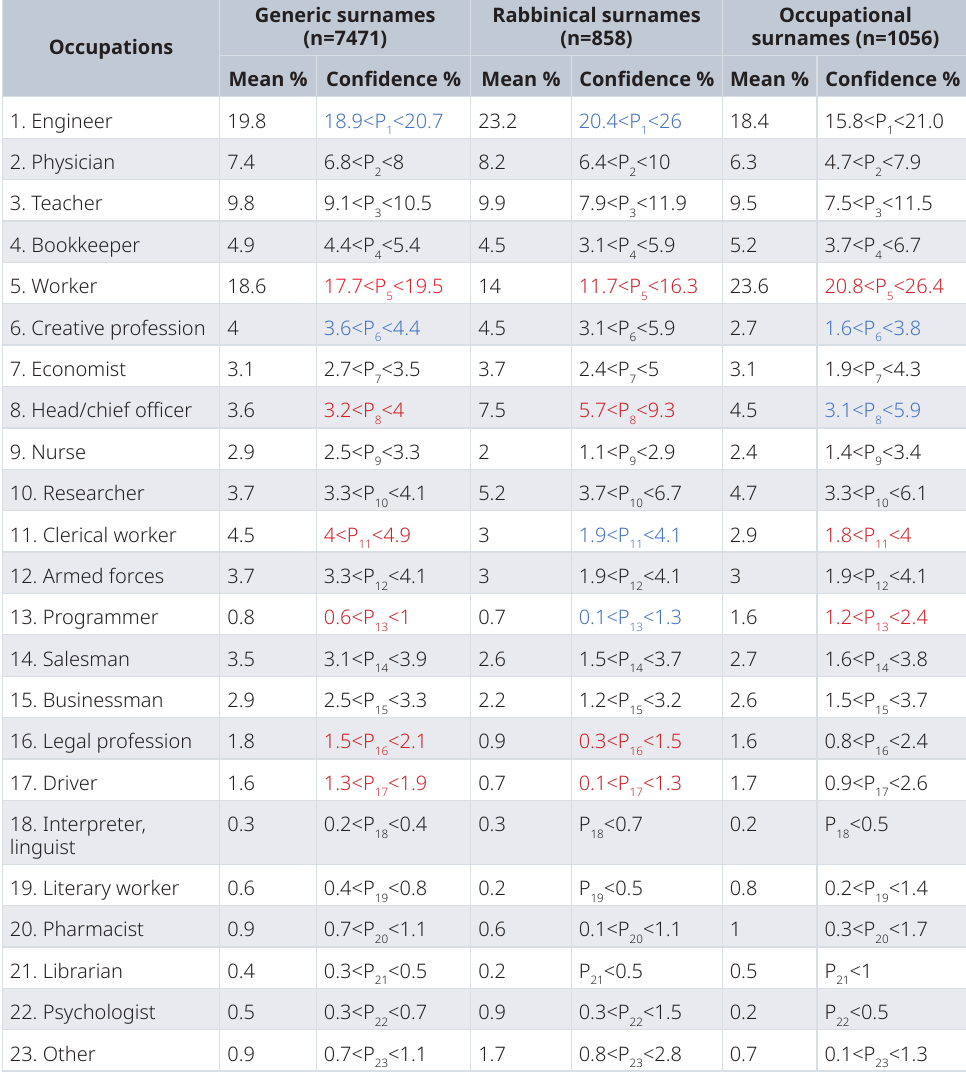
Table 7. Final occupational distributions of bearers of rabbinical, occupational and generic (neither rabbinical nor occupational). The table tests the hypothesis that the occupational distributions of the groups are identical by checking the overlap of the confidence intervals. Shares P i-th profession are provided for each group together with their 95% confidence intervals. The sizes of the respective pools are provided in the first row. Confidence intervals of generic surnames are significantly narrower than in other groups thanks to much larger pool of available data. Red indicates P different beyond the statistical error; blue indicates those that are different with high probability, e.g. would differ if we used 90% confidence